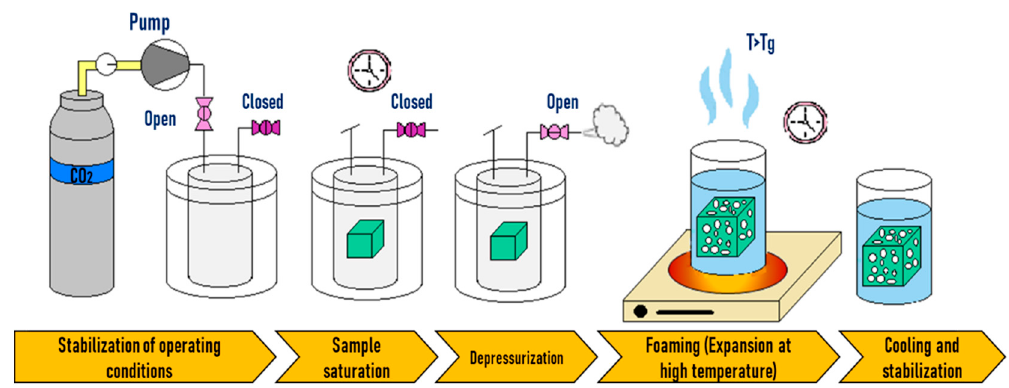
Figure 2. Principle of the temperature-induced batch foaming process. Adapted from Standau et al. [132].